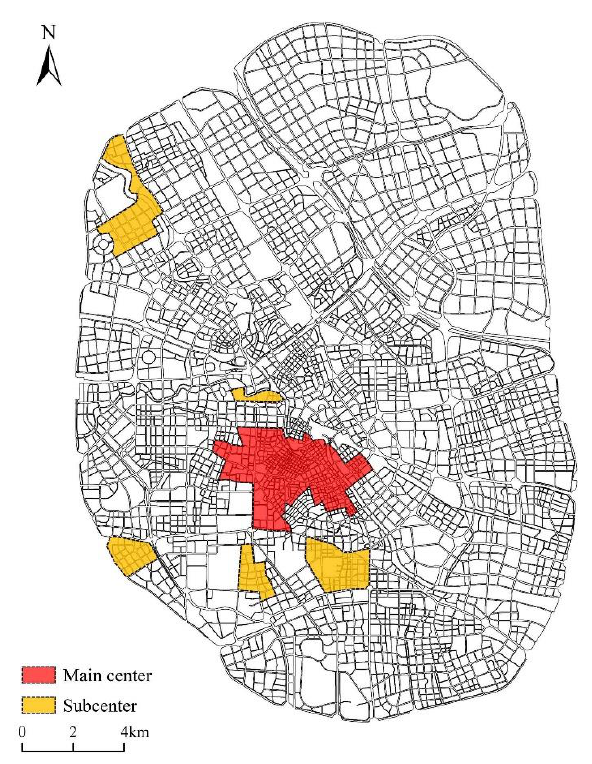
Figure 6. The main center and subcenter in Tianjin central area. Table 2. The number of jobs and job density of centers in Tianjin central area. Centers Number of Jobs